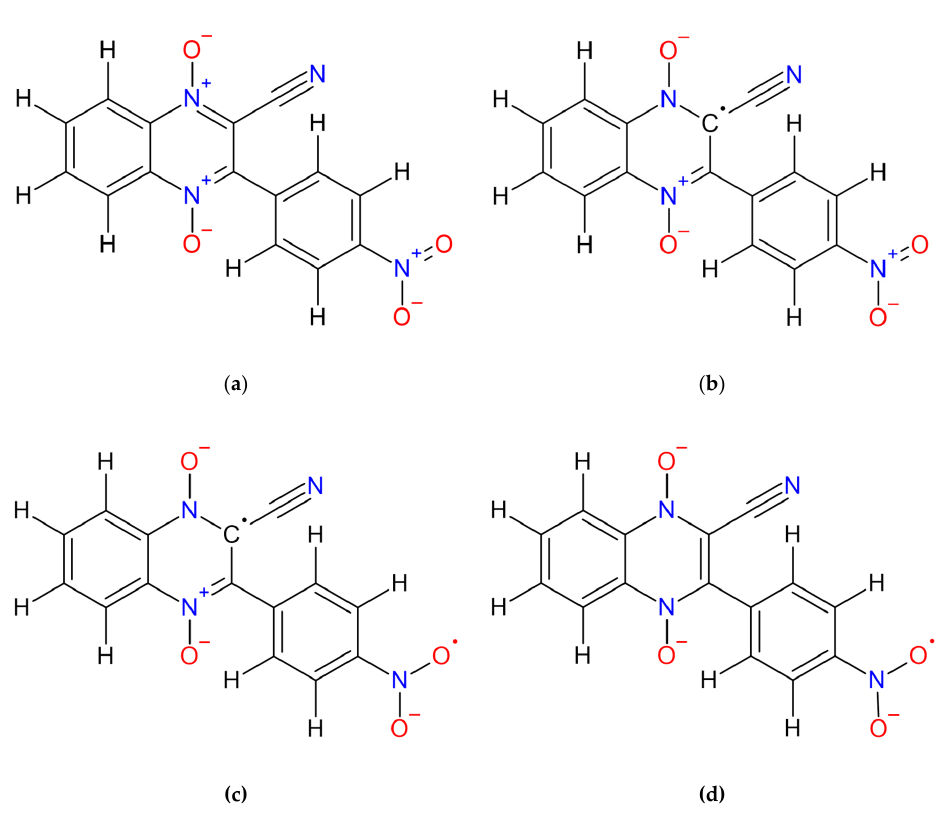
Figure 3. The structure of ( a ) the molecule, ( b ) the radical anion product of wave 1, ( c ) the diradical dianion product of the nitro wave, and ( d ) the radical trianion product of wave 2 for derivative E1. Chemical structures drawn in ChemSketch Freeware [19].